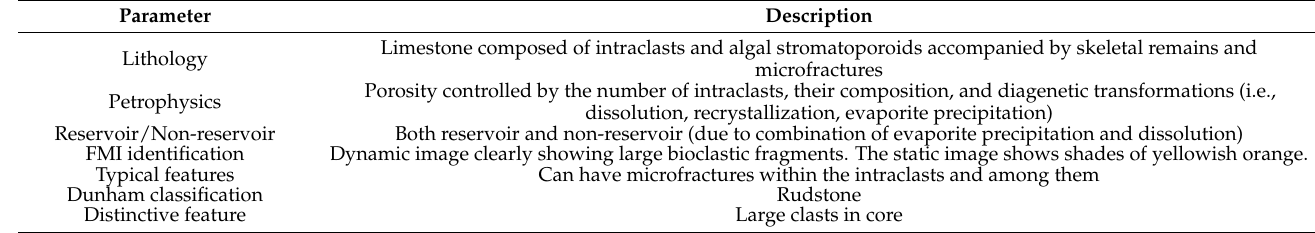
Table 4. Description of main reservoir parameters for RT3.